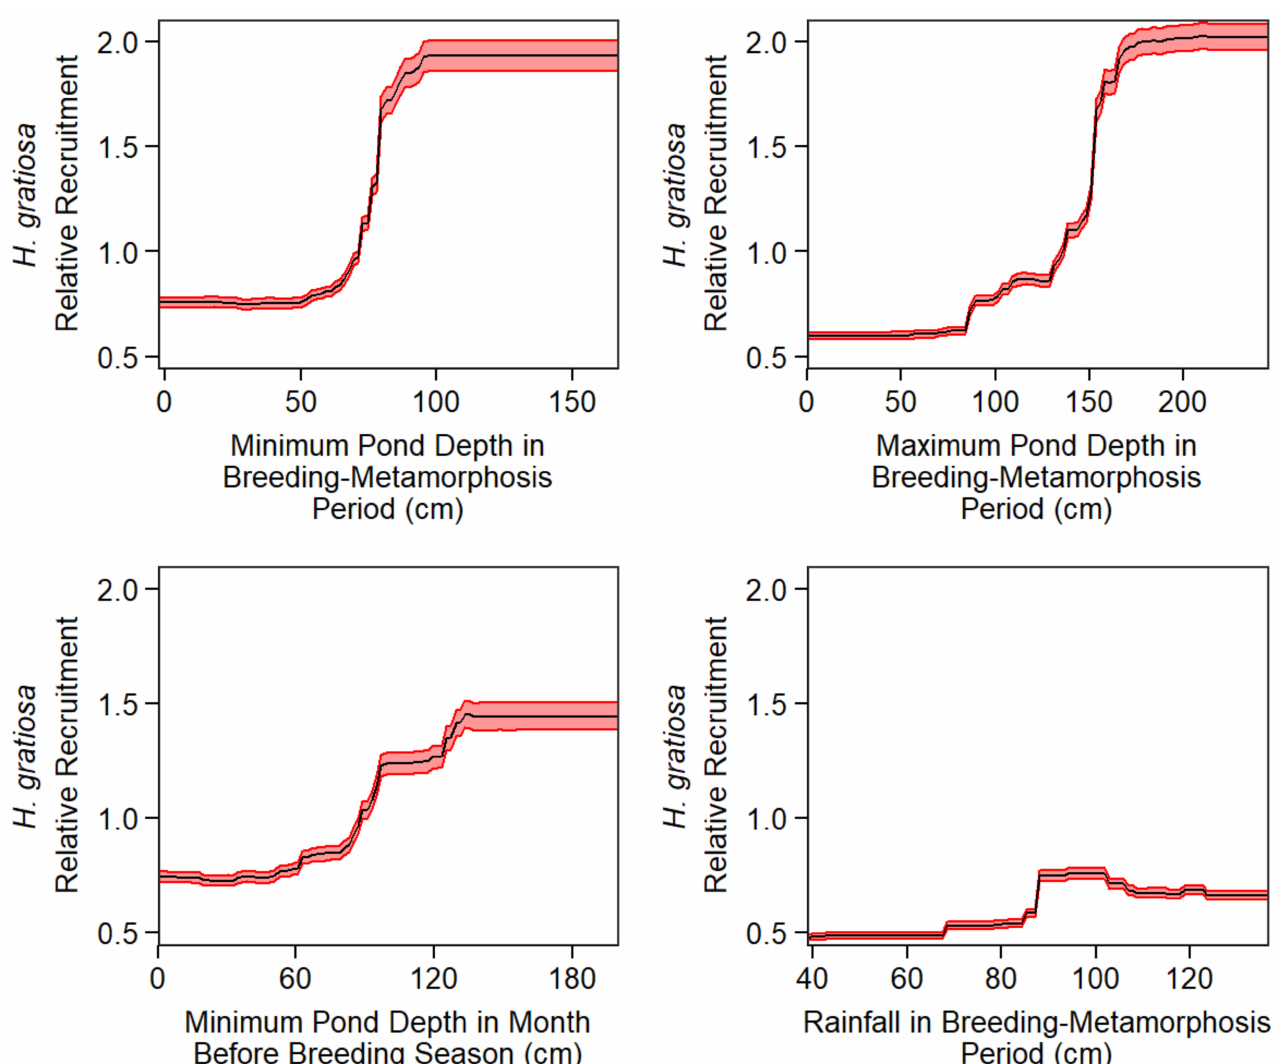
Figure 6. Influences of the four most important predictor variables (excluding pond ID) on relative annual H. gratiosa recruitment, Ocala National Forest, Marion County, Florida. Black lines represent mean predictions using BRTs; red ribbons represent standard